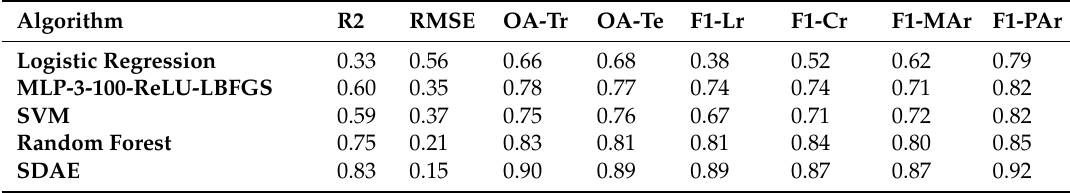
Table 4. Classification results for